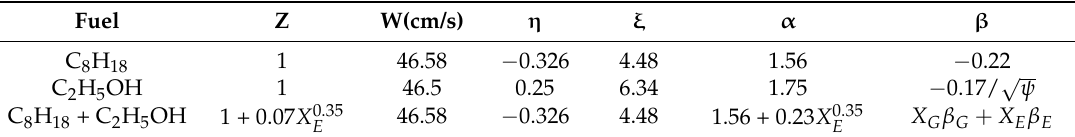
Table 3. Empirical coefficients for laminar flame speed.